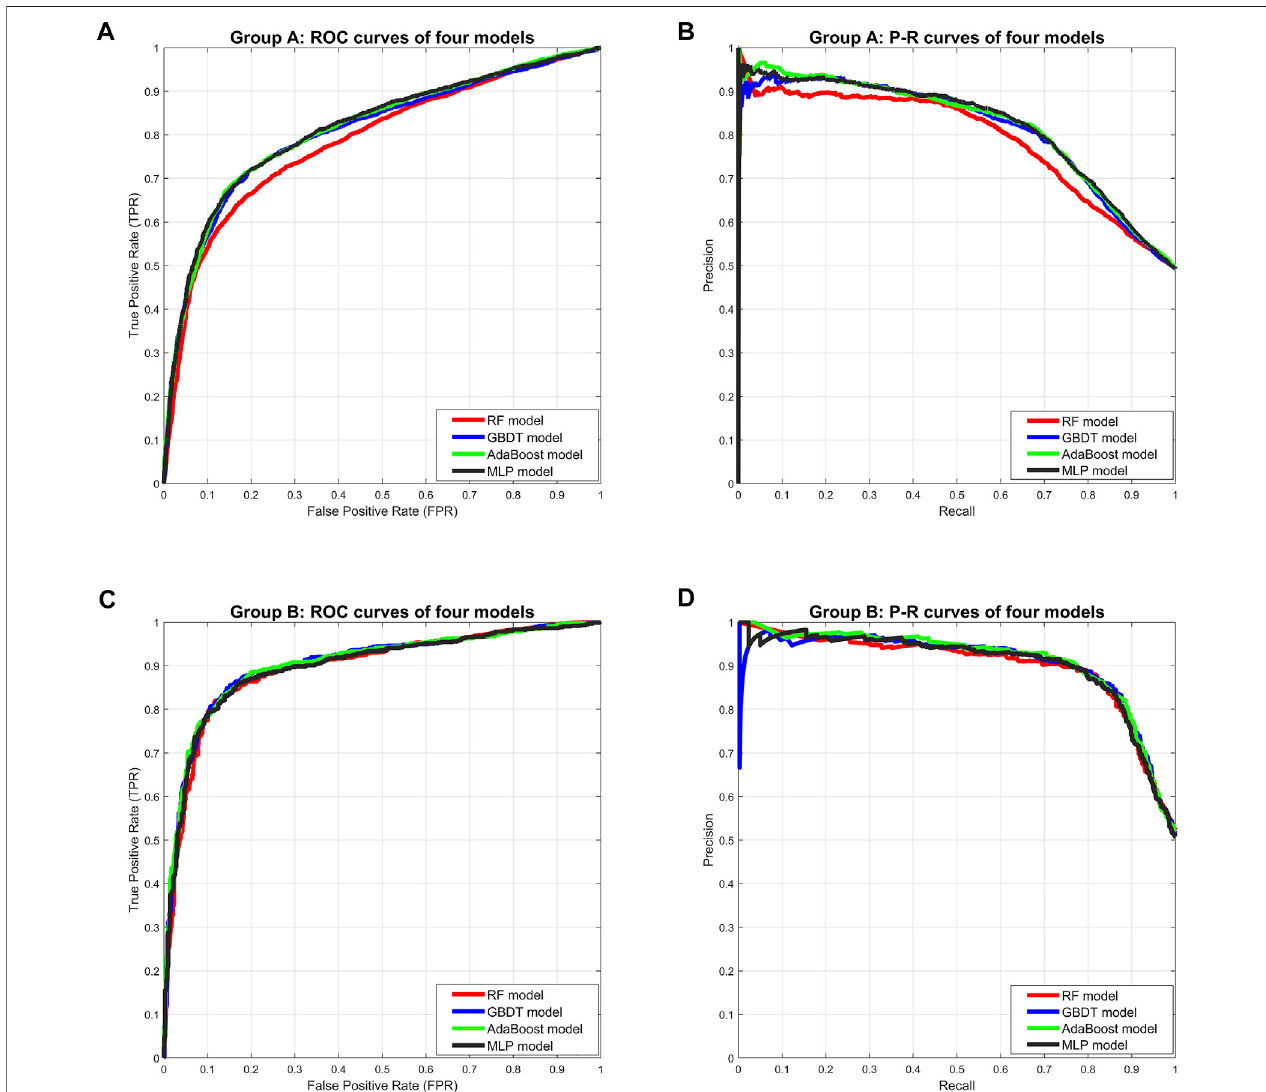
FIGURE4 | Comprehensive comparison offour models. (A) Comprehensive ROC curves offour models inGroup A: the larger thearea under the curve, thebetter the performance. (B) Comprehensive P-R curves of four models in Group A: the larger the area under the curve, the better the performance. (C) Comprehensive ROC curves of four models in Group B. (D) Comprehensive P-R curves of four models in Group B.